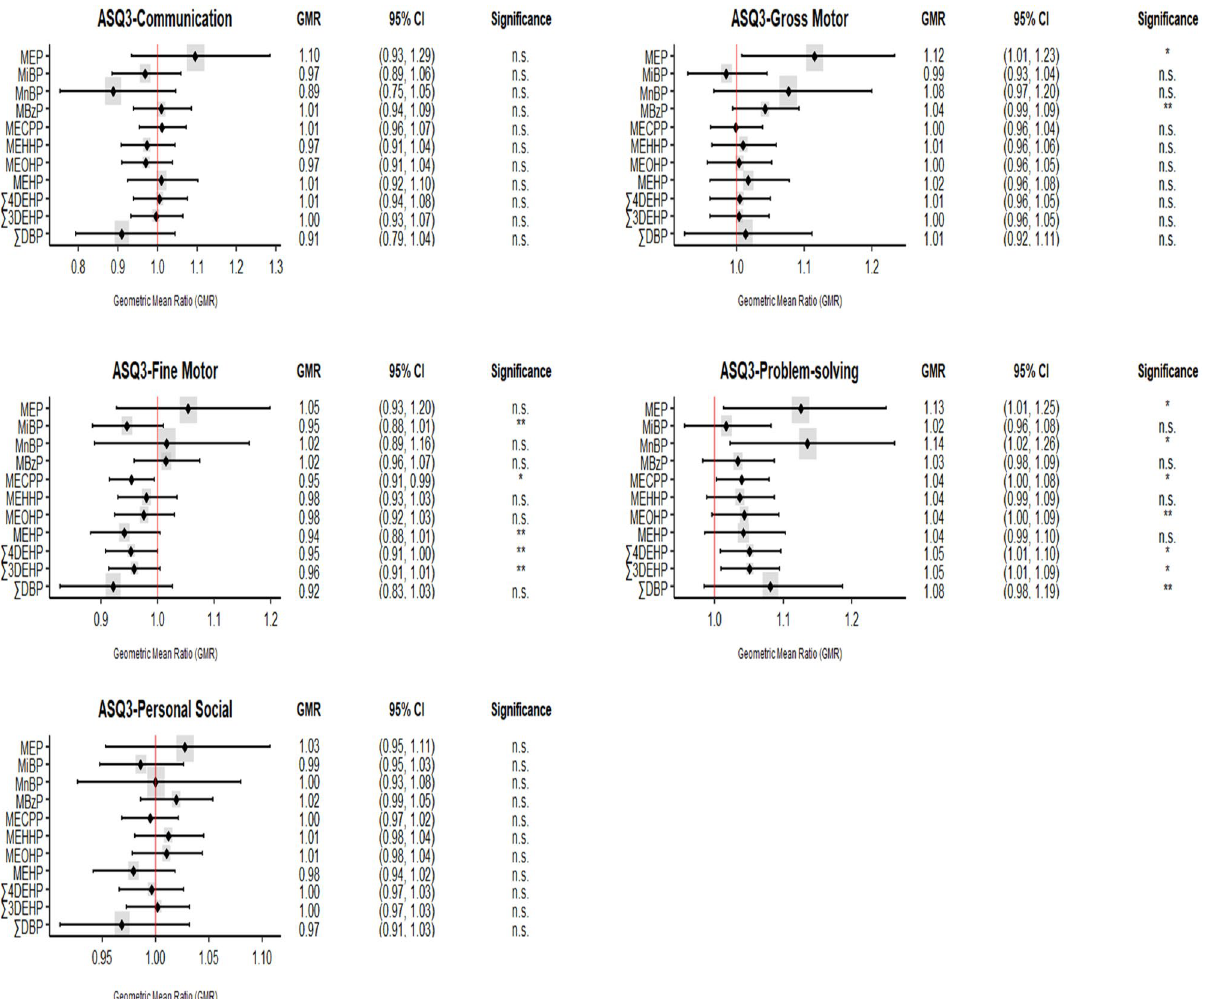
Figure 2. Forest plot showing adjusted associations between scores of the five ASQ-3 domains and urinary phthalate metabolites. The estimated effects presented as geometric mean ratio (GMR) and 95% confidence intervals (95% CIs). The vertical red line represent no effect and the horizontal lines represent the 95%CI. Confidence intervals that do not cross the red vertical line are significant at * p < 0.05 or ** p < 0.1; n.s.: not